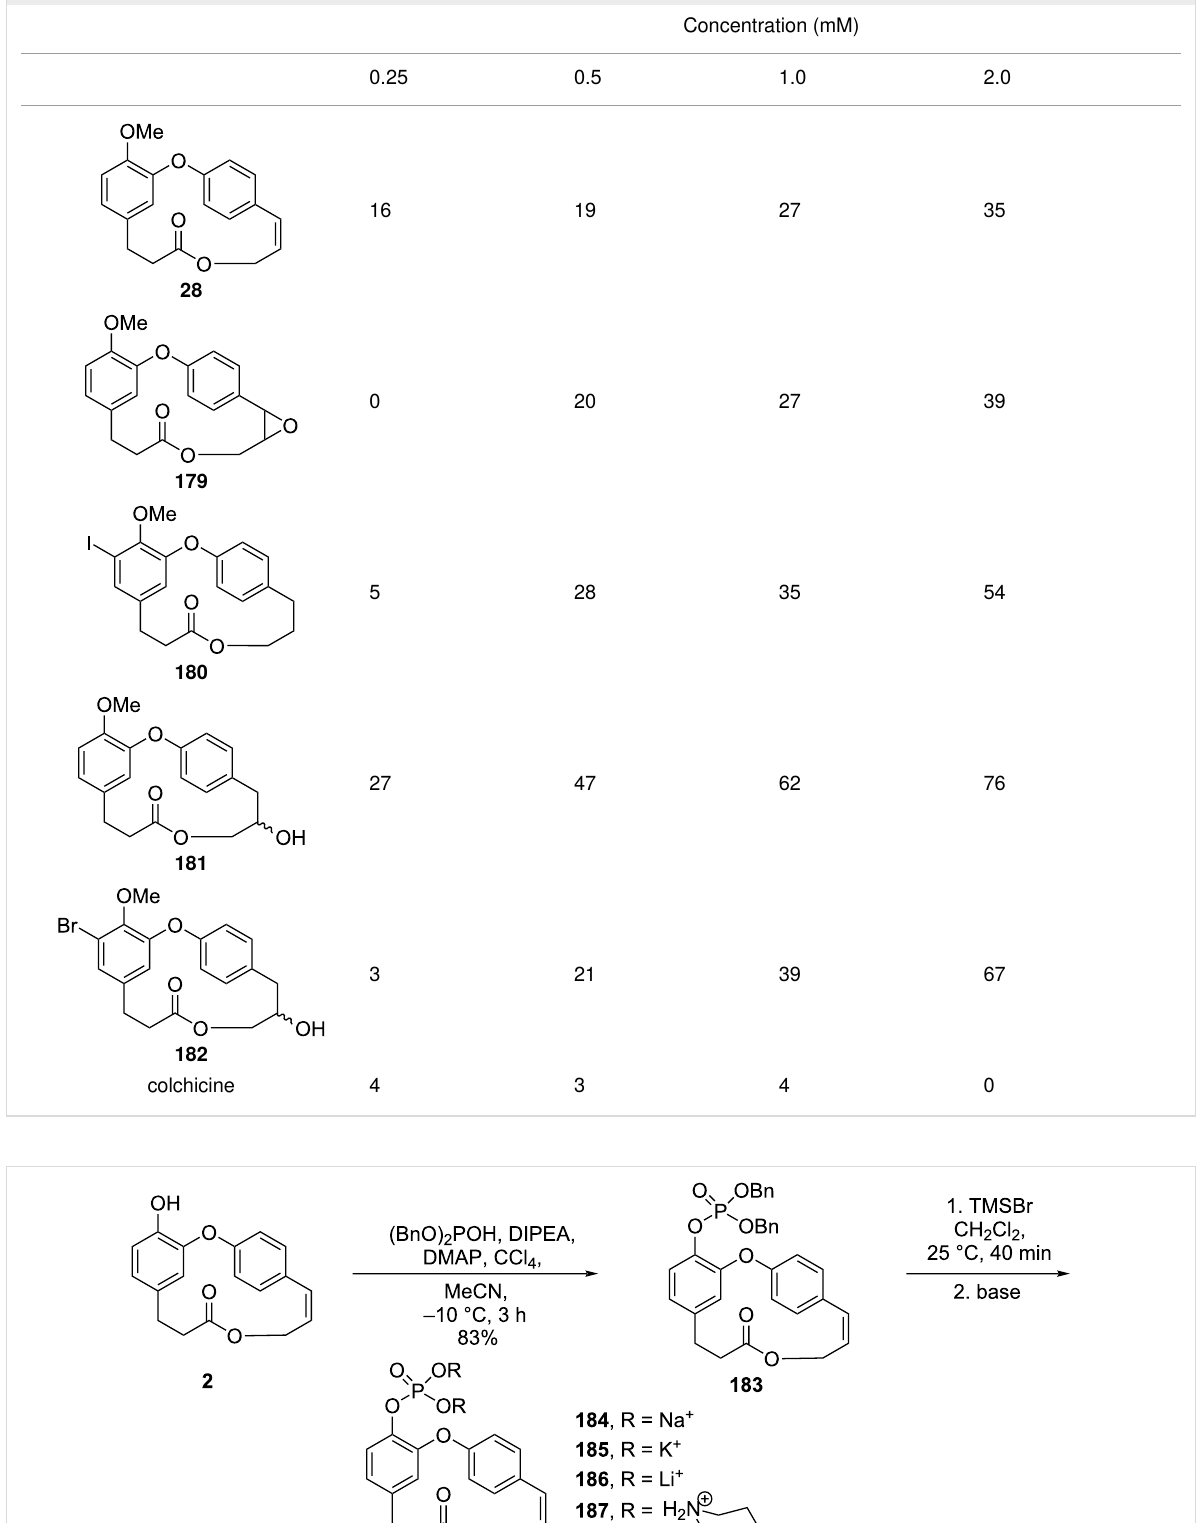
Table 2: Effect of combretastatin D derivatives on tubulin polymerization (%) [73].